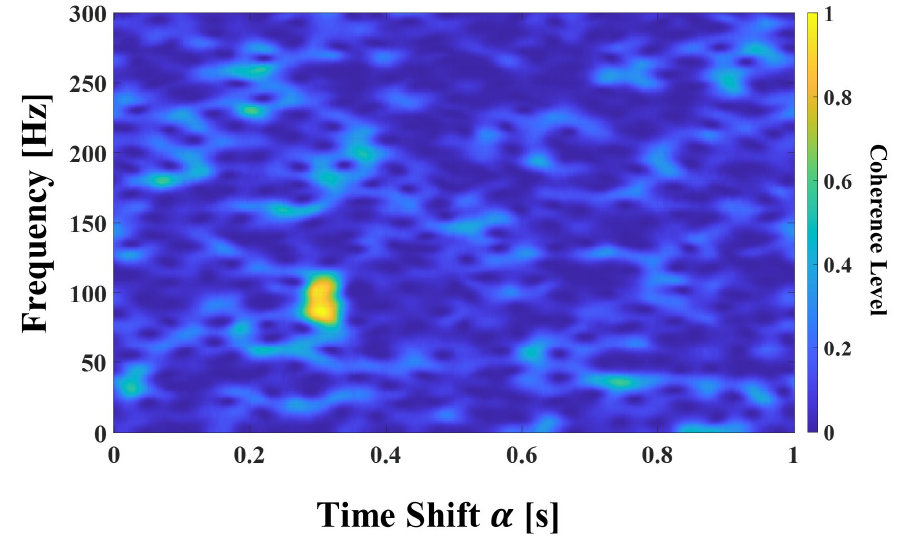
Figure 8. Results of time-shift coherence using transient signals .